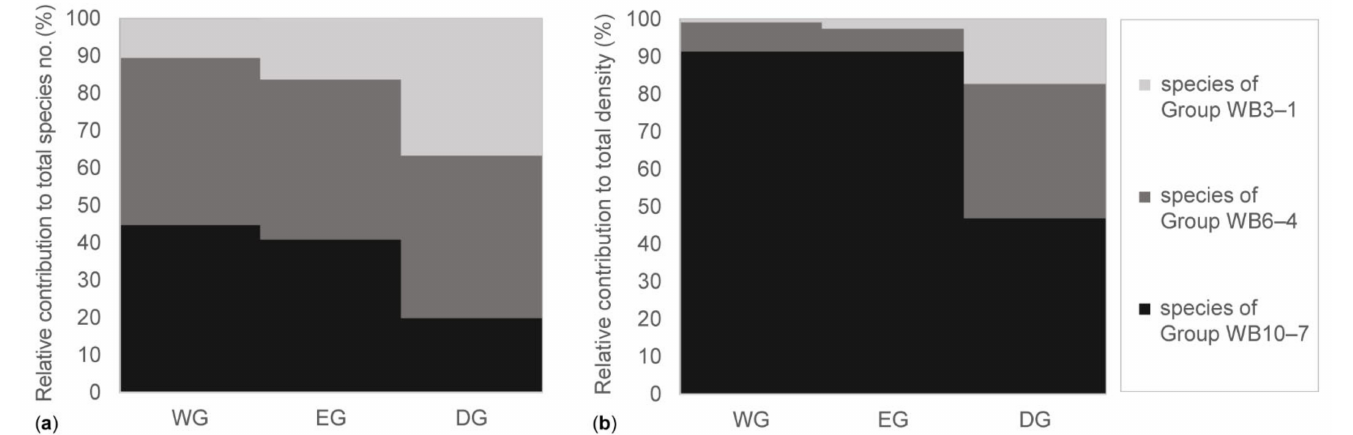
Figure 3. Relative contribution to the total species number ( a ) and to the total density ( b ) by the species belonging to the given WB groups in the soil seed bank of the three grassland types. Notation: WG—wet grassland type; EG—ecotone grassland type; DG—semi-dry grassland type; WB groups were created by grouping the WB categories from the system of Borhidi [31], where “Group WB10–7” was for species that are most associated with high, “Group WB6–4” was for species that are associated with moderate, and “Group WB3–1” was for species that are most associated with low soil moisture